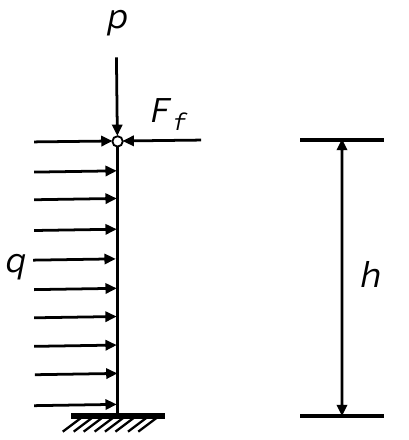
F -frictional resistance F f between the coal . , the model